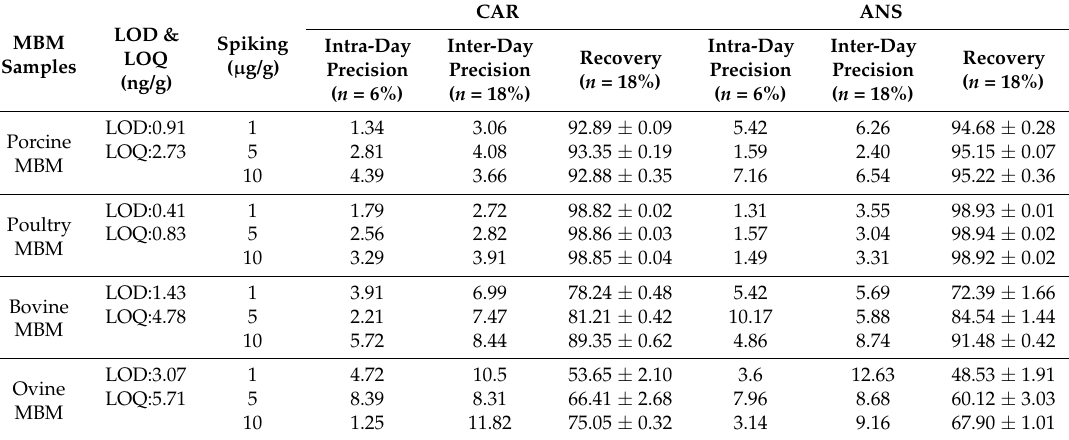
Table 3. Instrumental quality parameters of the developed method to determine carnosine (CAR) and anserine (ANS) in four types of MBM